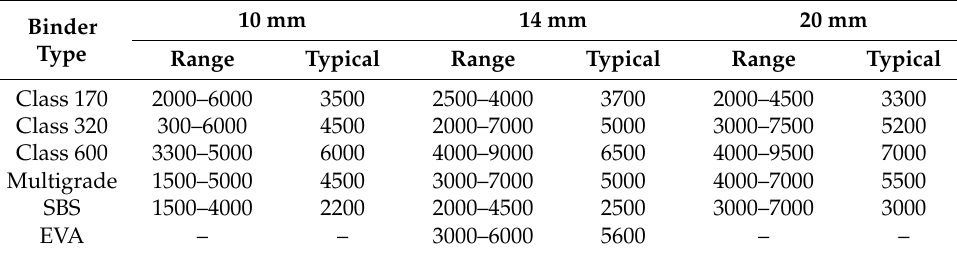
Figure 4. Resilient modulus test results of different asphalt mixtures. Table 6. Typical resilient modulus values for various mixes in Australia